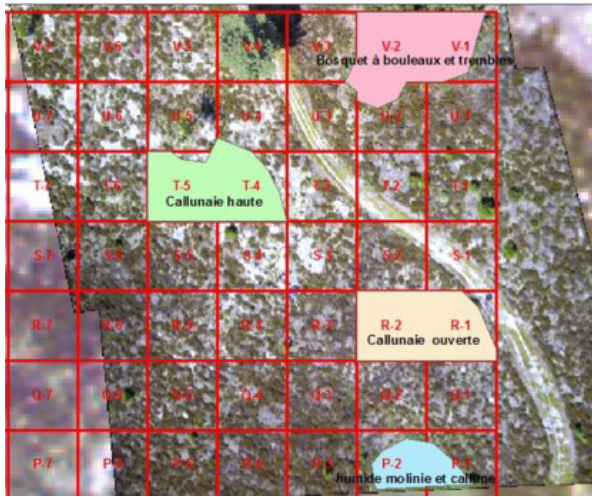
Figure 10: An example of fine species land-cover that can be made with the high resolution mosaics produced (courtesy of S. Mobaied).